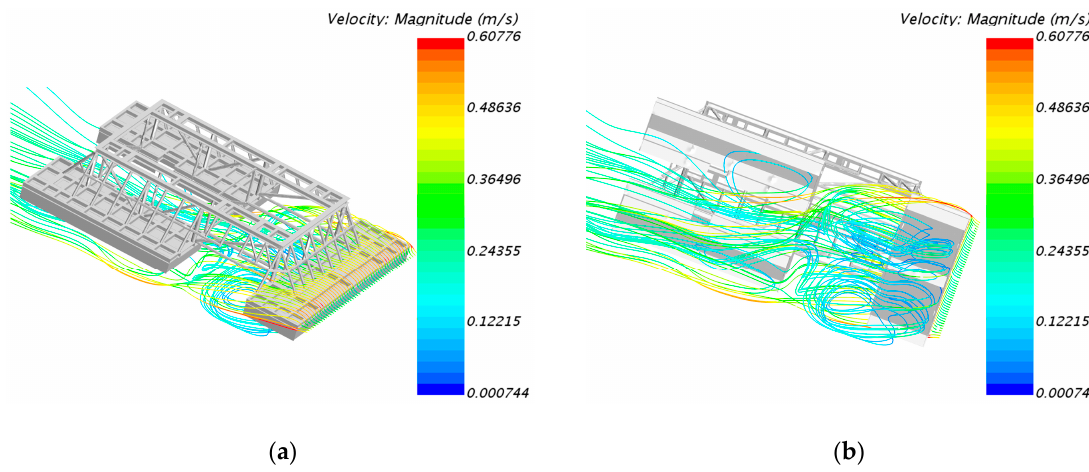
Figure 19. Perspective view of streamlines from the inlet section in Case 10: ( a ) top view of the flow field, ( b ) bottom view of the flow field.